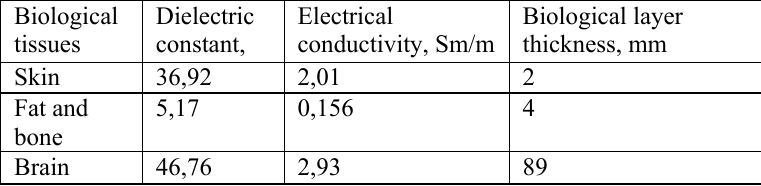
Table 1. Averaged electrophysical parameters of biological tissues of the human